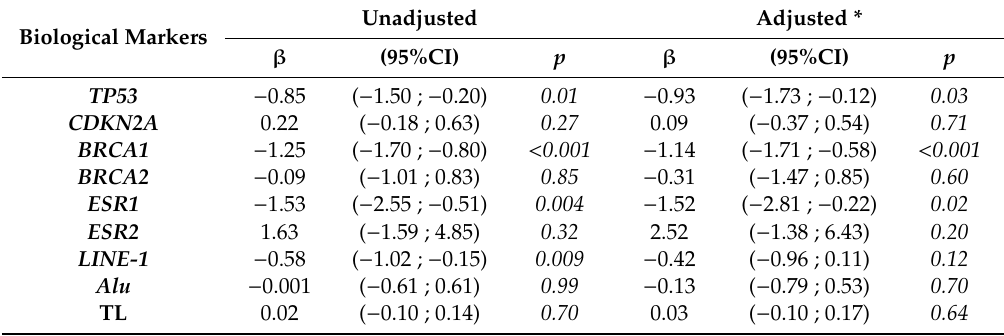
Table 3. Association between night shift work (ever ( N = 69) vs. never ( N = 28) night shift workers) and gene-specific methylation, methylation of repetitive elements, and telomere